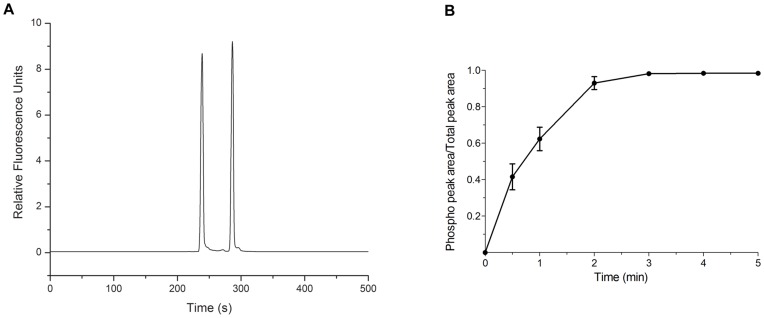
Assessment of Src kinase catalytic activity.(a) CE-LIF separation and visualization of the Src peptide substrate 1 and its chemically synthesized phosphorylated counterpart 2. (b) Src kinase-catalyzed phosphorylation of peptide 1 as a function of time as assessed by CE-LIF.